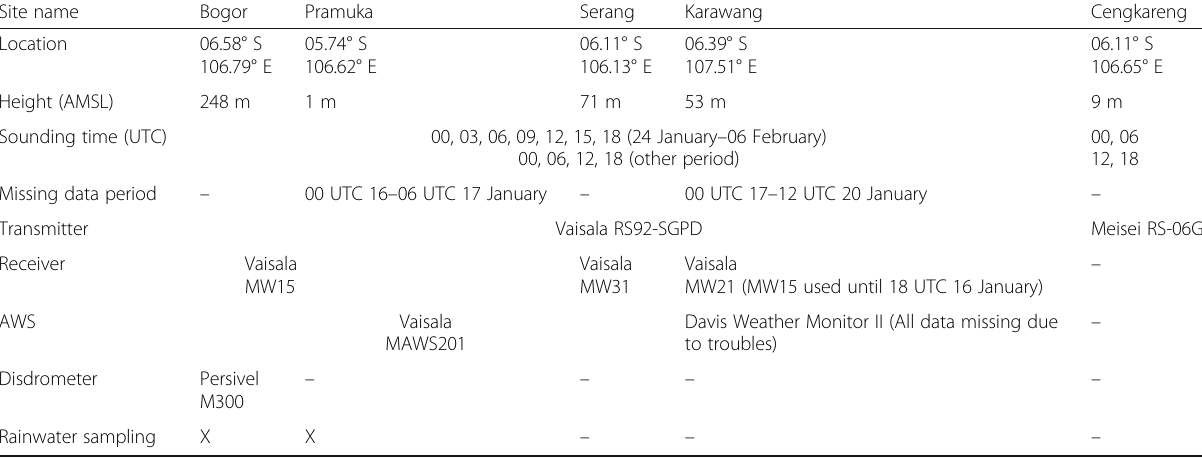
Table 2 Specifications of intensive sounding network during the HARIMAU2010 campaign. (00 UTC 16 January – 24 UTC 14